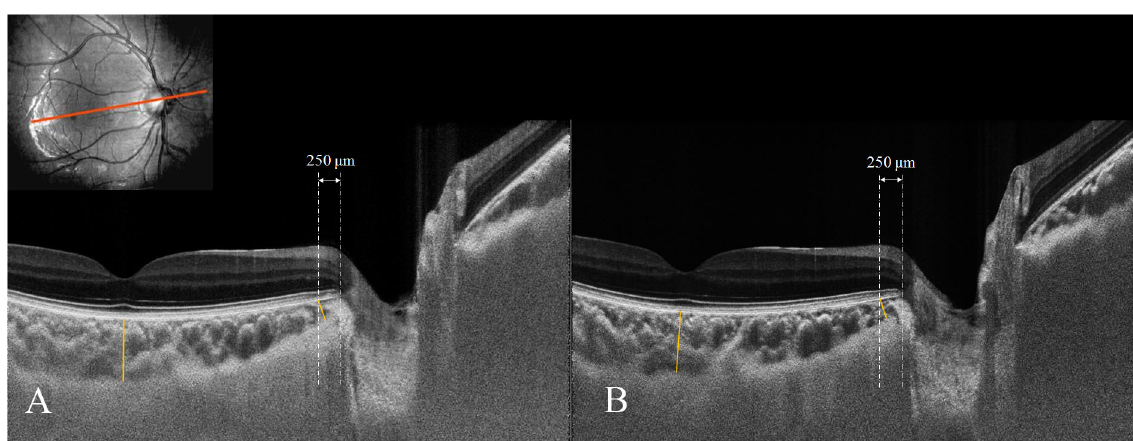
Fig 3. Choroidal thickness change during standardized Valsalva maneuver. Enhanced depth imaging (EDI) scan aligned to axis connecting fovea and center of optic disc in 22-year-old male. Note that adaptive compensation was performed to enhance choroid visibility. Choroidal thickness was defined as the vertical distance between the outer border of the retinal pigment epithelium and the inner surface of the sclera. The peripapillary chorodidal thickness was measured at the point 250 μ m temporally from the termination of the Bruch ’ s membrane openings (BMO). The subfoveal choroidal thickness (A) was 336 μ m at baseline and 324 μ m during the standardized Valsalva maneuver. The peripapillary choroidal thickness (B) was 154 μ m at baseline and 146 μ m during the standardized Valsalva